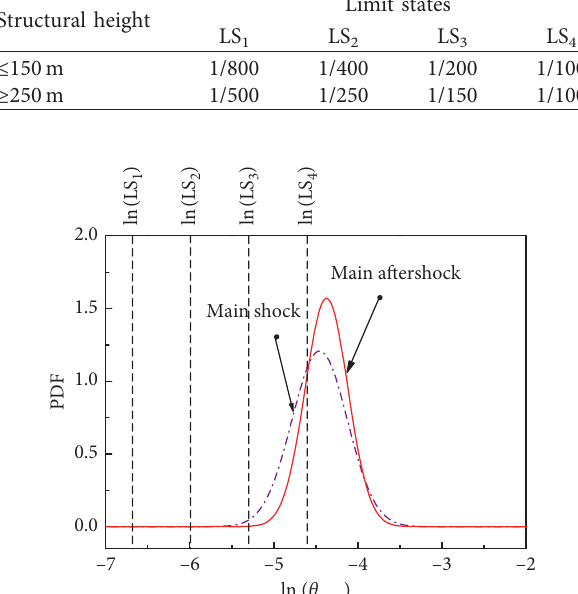
Figure 14: PDF of structural requirements ( S